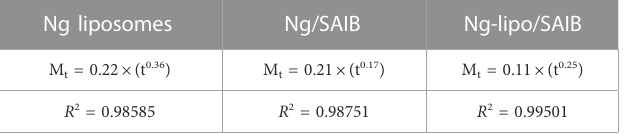
TABLE 2 Evaluation of drug release kinetics of SAIB-based depots according to the Ritger-Peppas equation. Ng liposomes Ng/SAIB